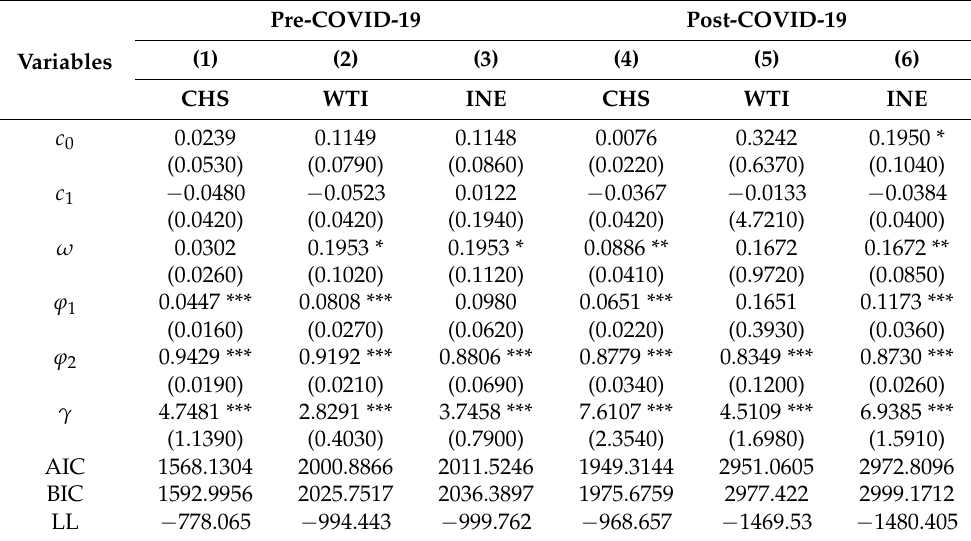
Table 4. Estimate results of marginal distribution based on the AR (1)-GARCH (1,1) model (pre-and post-COVID-19 subsamples).